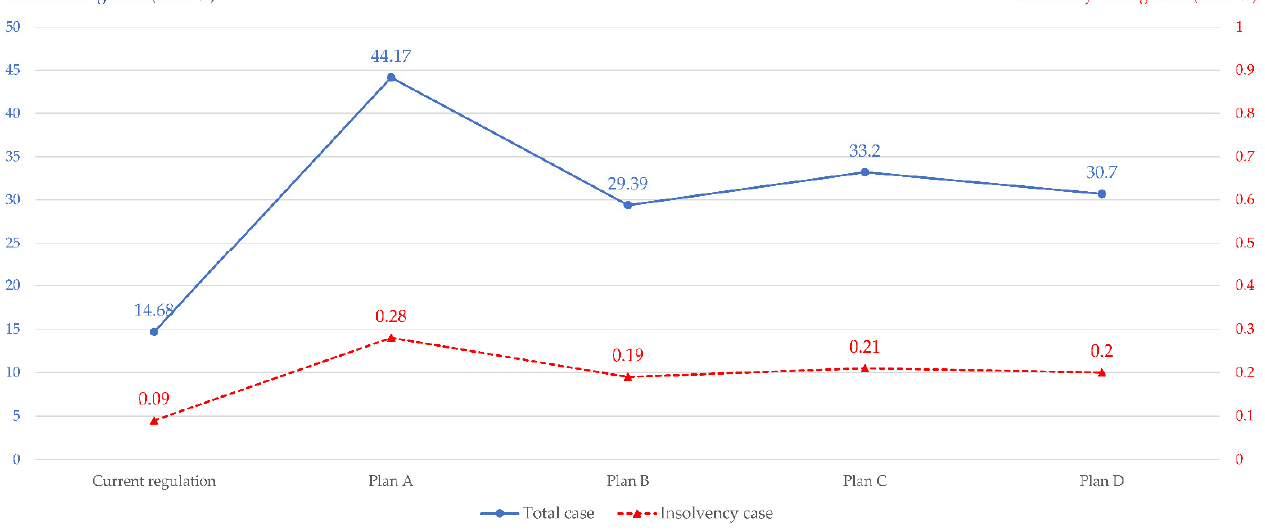
Figure 3. Comparison of defect damage and insolvency damage.